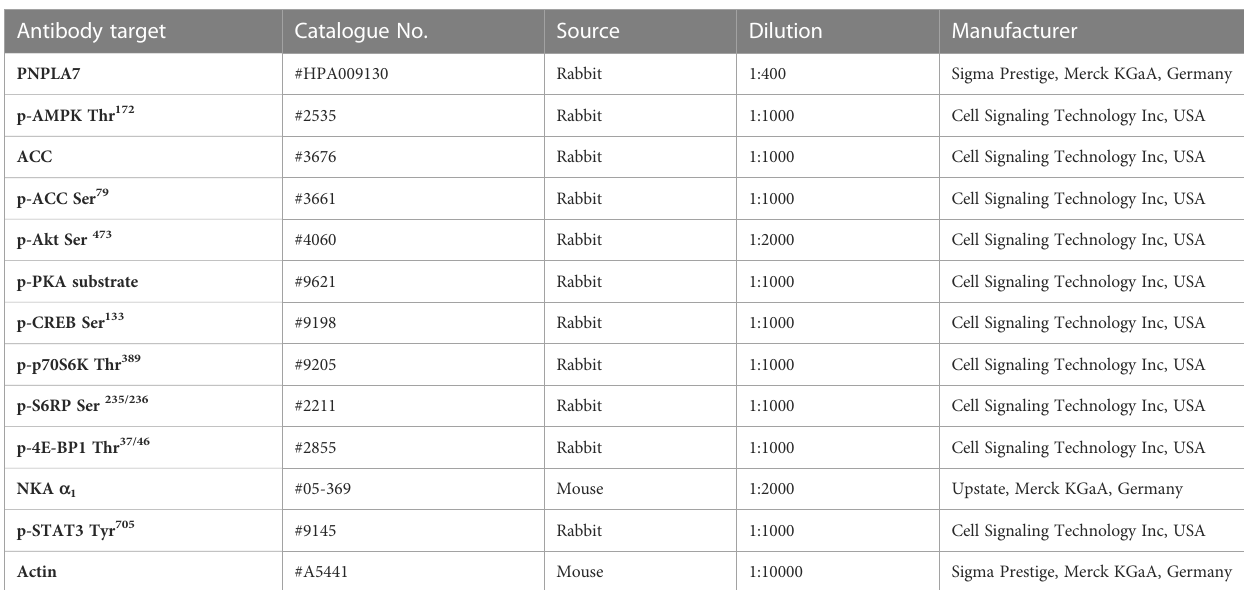
TABLE 1 List of primary antibodies used for